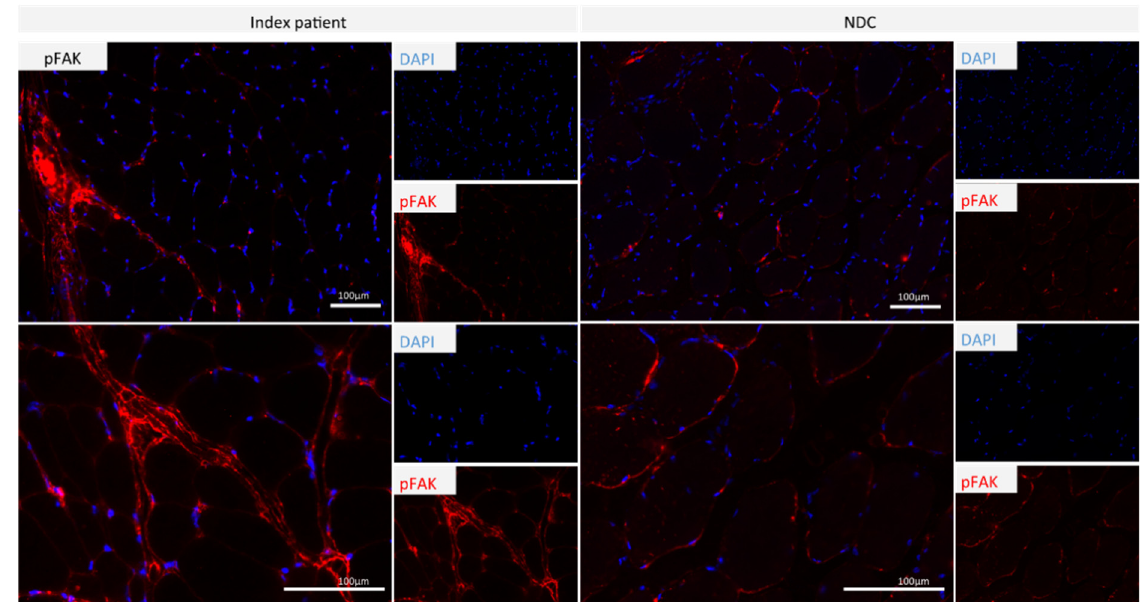
Figure 5. Immunofluorescence studies focusing on phosphor-FAK1 (pFAK) in quadriceps muscle biopsies derived from the p.(A20S)-SPTLC1-patient and a control: phospho-FAK1 is expressed in the sub-sarcolemmal region of muscle fibers derived from the healthy control, whereas in the biopsy derived from the patient, phospho-FAK1 is upregulated in perimysial areas and in immune cells.